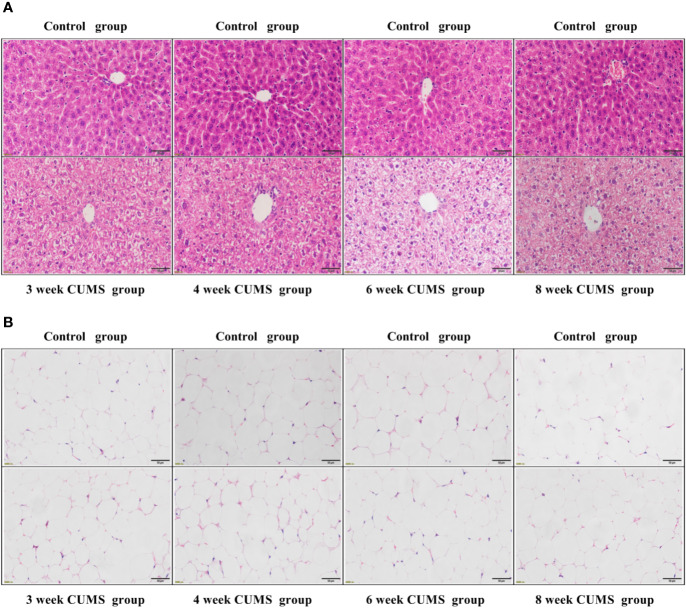
The influence of CUMS on hepatocytes and adipocytes using H&E staining. (A) Representative micrographs of rat liver tissues under a light microscope (scale bar = 50 μm, 400× magnification). (B) Representative micrographs of abdominal adipose tissues under a light microscope (scale bar = 50 μm, 400× magnification).